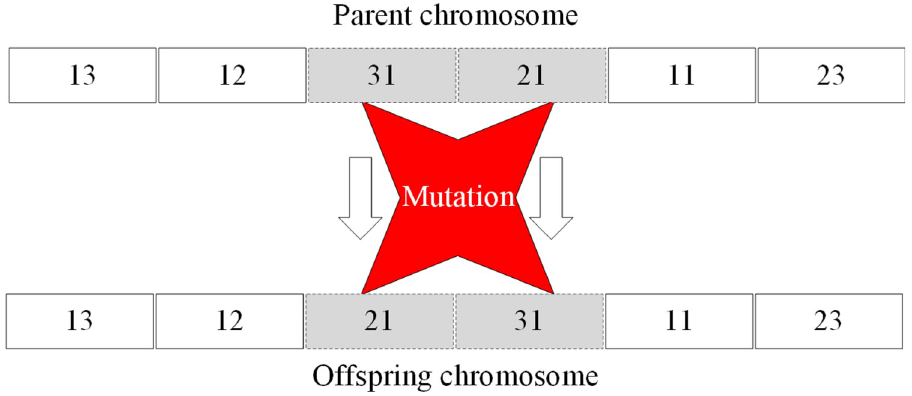
Fig 10. Mutation operation process of